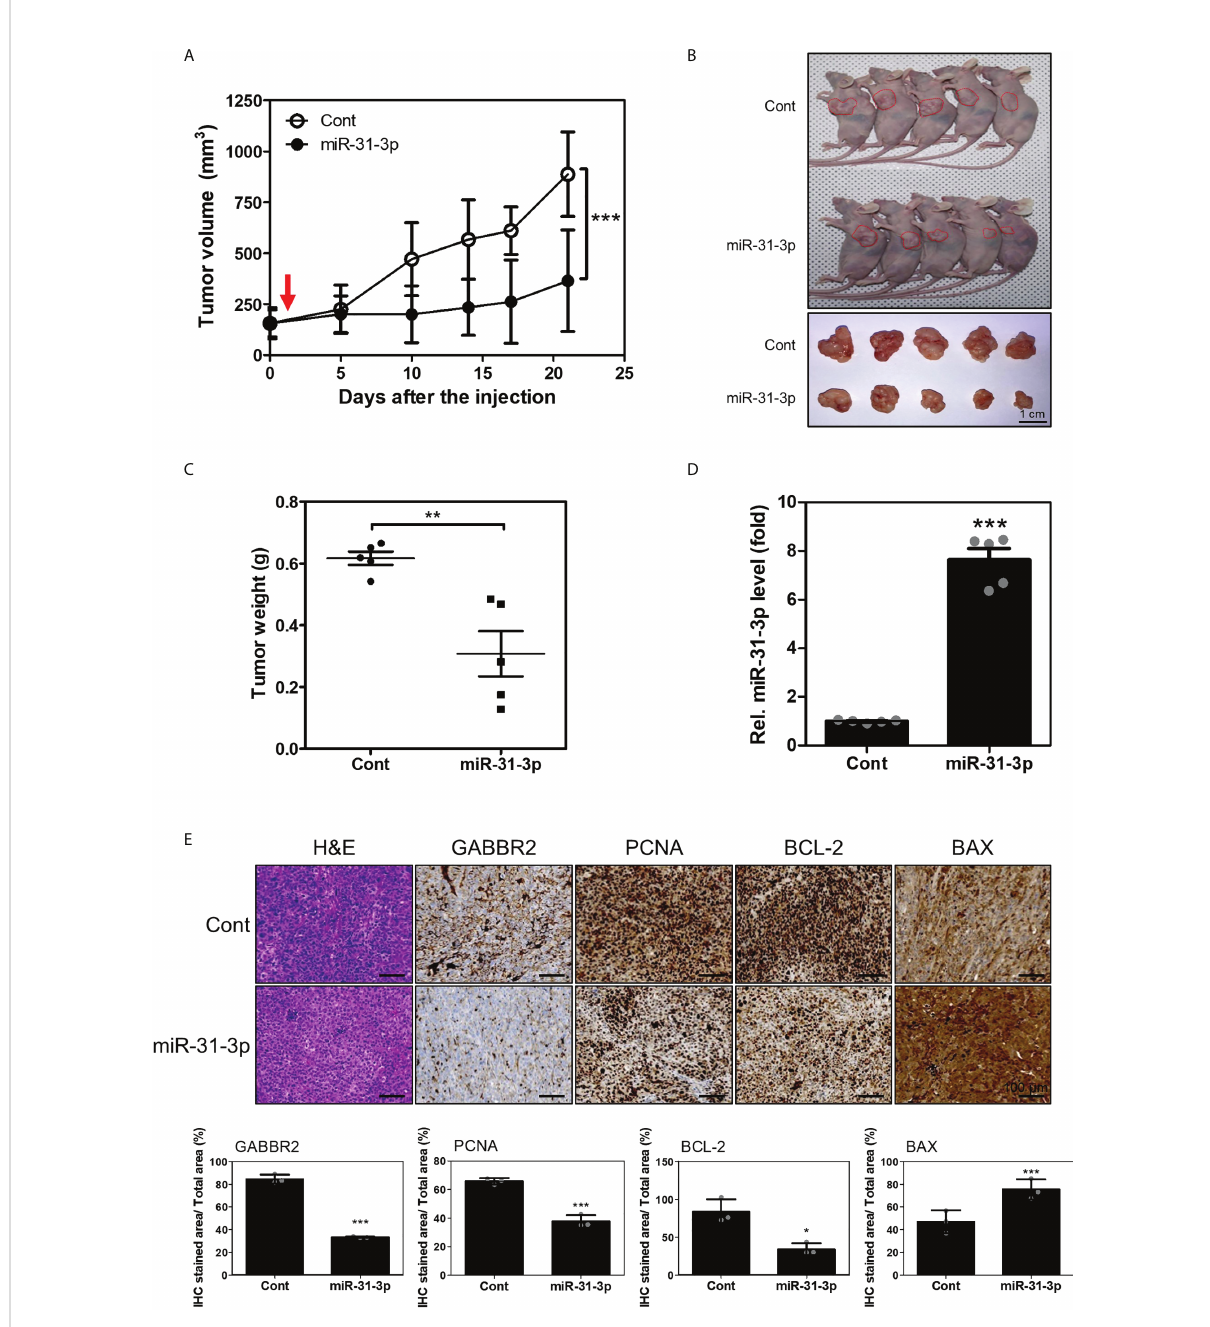
FIGURE 5 miR-31-3p suppresses in vivo tumor growth rate. (A) miR-31-3p suppresses tumor growth rate in mouse DU145 cell xenografts (n = 5 per group). An unpaired two-tailed Student ’ s t -test was used to calculate P values. Error bars represent mean ± standard error of the mean. *P value < 0.05 and ***P value < 0.001 vs. Cont (n = 5). (B) Representative images of tumors on the shoulders of mice after tumor resection. (C) Comparison of tumor weight distributions. An unpaired two-tailed Student ’ s t-test was used to calculate P values. Error bars represent mean ± standard error of the mean (SEM). **P value < 0.005 vs. Cont (n = 5). (D) Con fi rmation of miR-31-3p induction in tumors of mice transfected with control miRNA or miR-31-3p. RNU6B was used as the reference gene for normalization. An unpaired two-tailed Student ’ s t -test was used to calculate P values. Error bars represent mean ± standard error of the mean (SEM). ***P value < 0.001 vs. Cont (n = 5). (E) Immunohistochemical analysis of tumor tissue sections to determine the expression of GABBR2 and related proteins. An unpaired two-tailed Student ’ s t -test was used to calculate P values. Error bars represent mean ± standard error of the mean (SEM). *P value < 0.05 and ***P value < 0.001 vs. Cont (n =